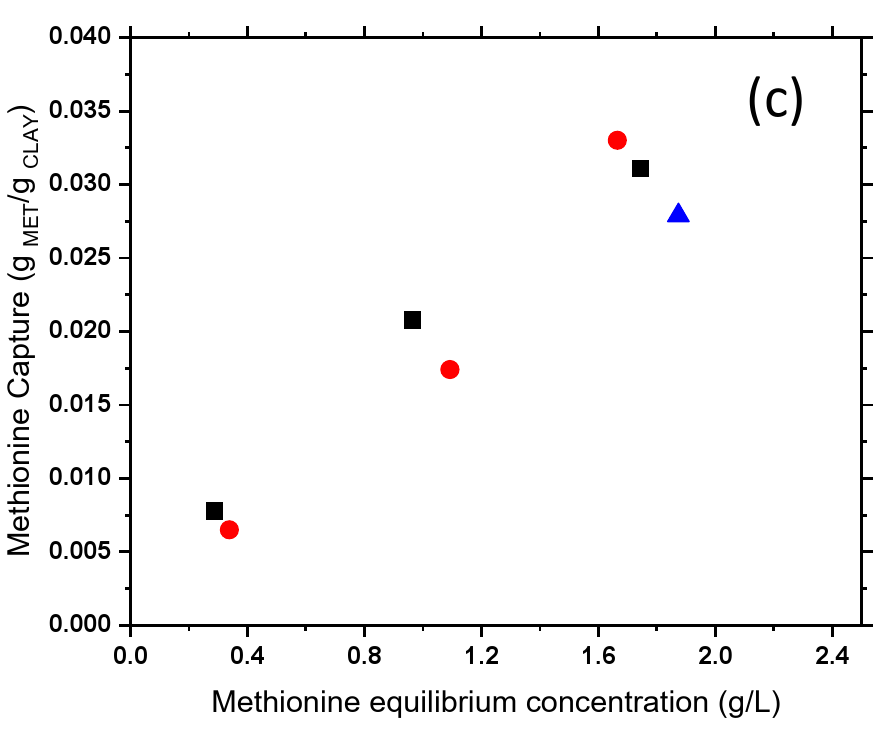
Figure 4. Comparison between ( a ) capture capabilities (open symbols: MET–ADS and MET–VEG washed once and twice); ( b ) adsorption isotherms (lines: Freundlich model); ( c ) isotherms in the 0–0.25 g/L range of methionine equilibrium concentration.